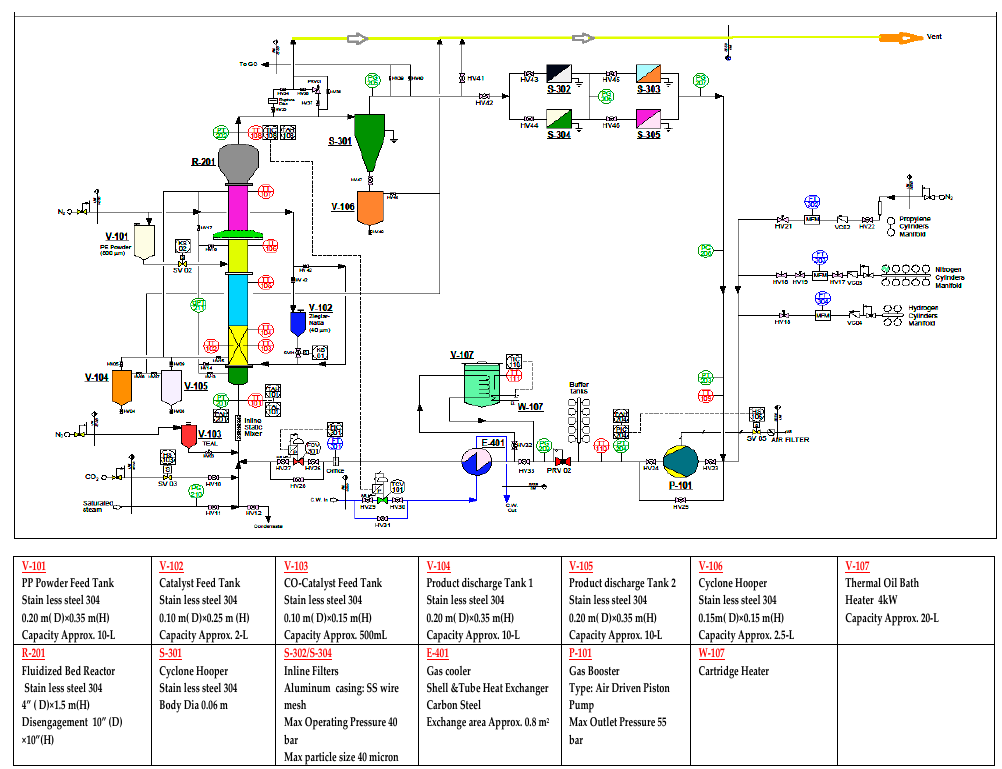
Figure 1. Detailed process diagram of fluidisation of the polypropylene production system.